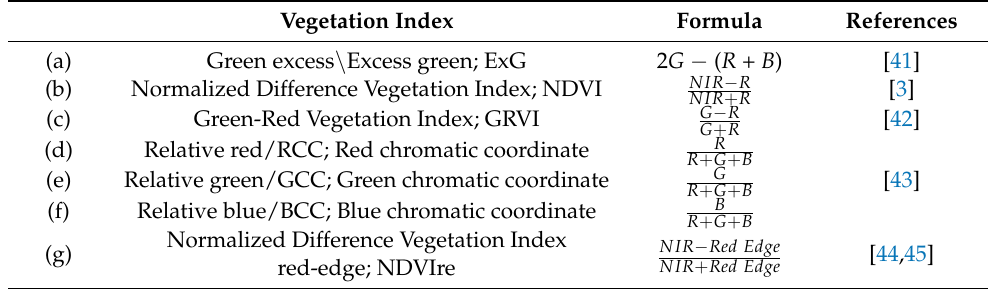
Table 1. Vegetation indices calculated for the ground camera (a–f), UAV and VEN µ S data (a–g).